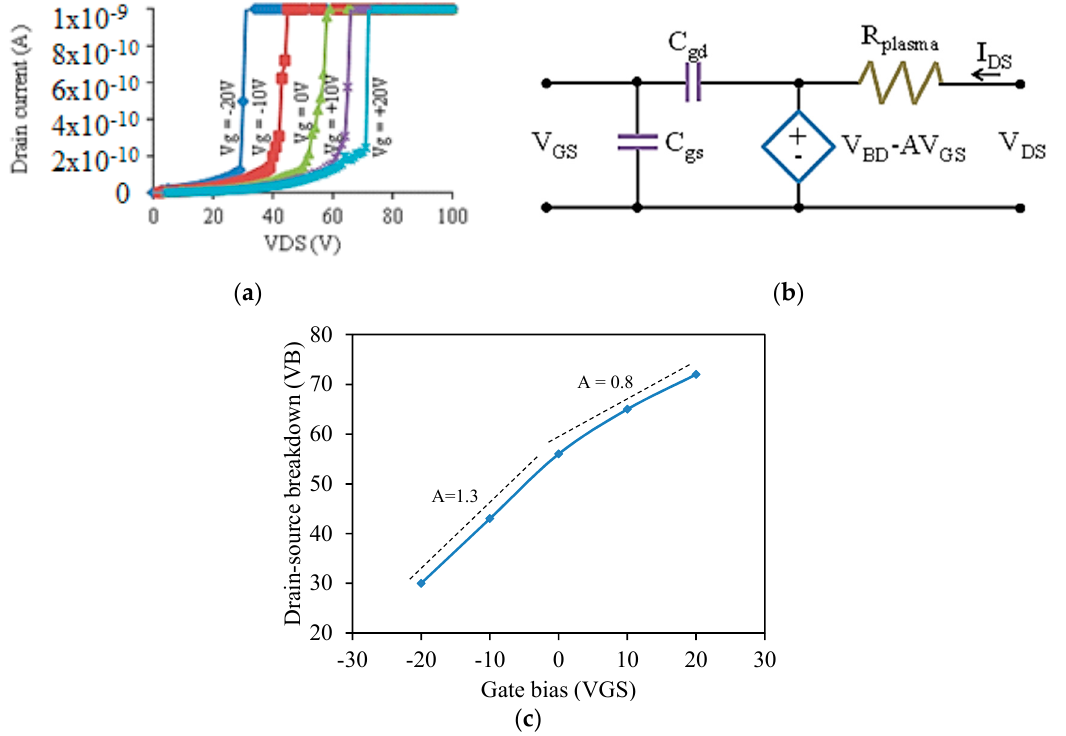
Figure 11. ( a ) I-V characteristics of a 1 μ m gap MOPFET. ( b ) A simple two port hybrid-pi model of the MOPFET. The constant voltage source plays a central role in the model and characterizes the accuracy of gas breakdown voltage. ( c ) The voltage gain as a function of gate bias clearly showing the gate field effect [25].